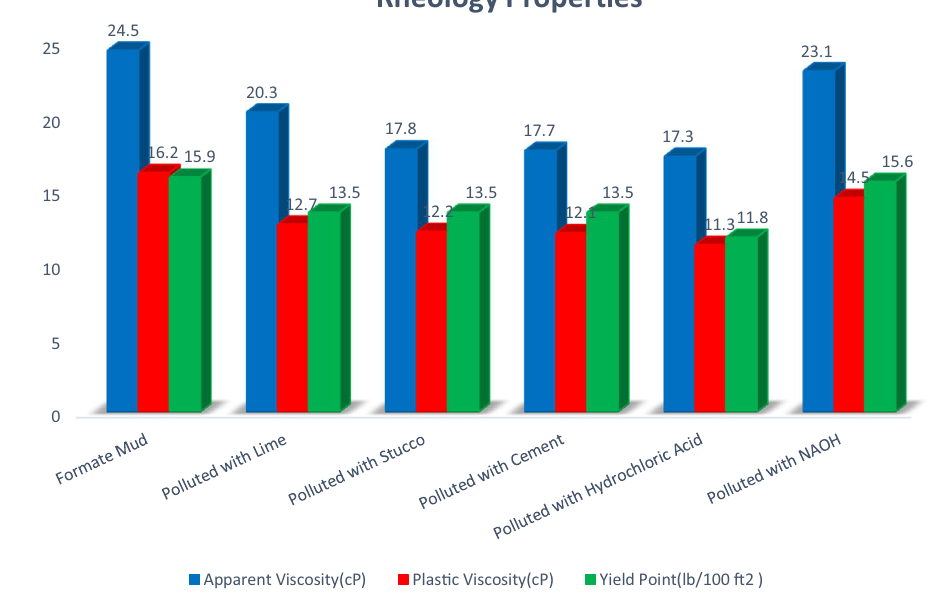
Fig. 3 Mud rheological proper- ties changes in the presence of several